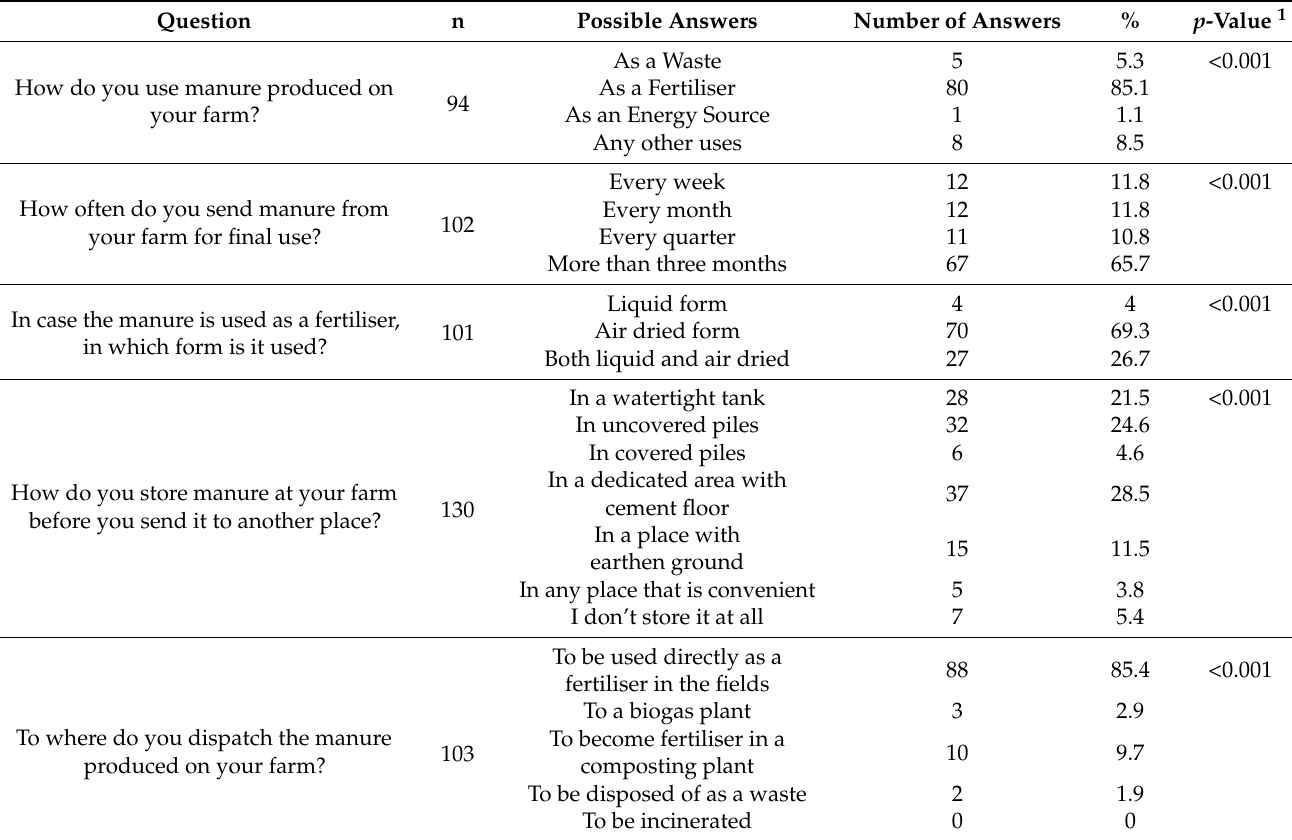
Table 2. Practices applied by participants for manure